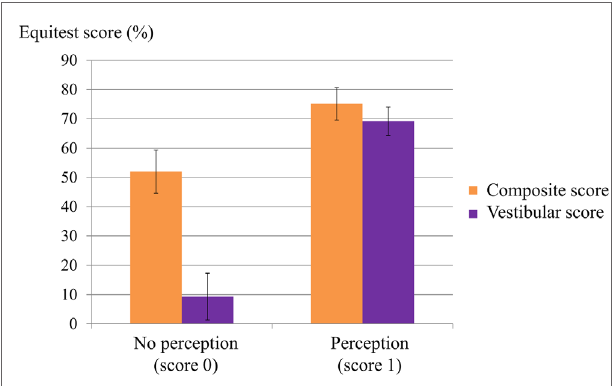
FigUre 4 | relation between composite and vestibular score on the equitest and the perception score during caloric irrigation. Most patients with a low perception score had a poor vestibular score on the Equitest and a low composite